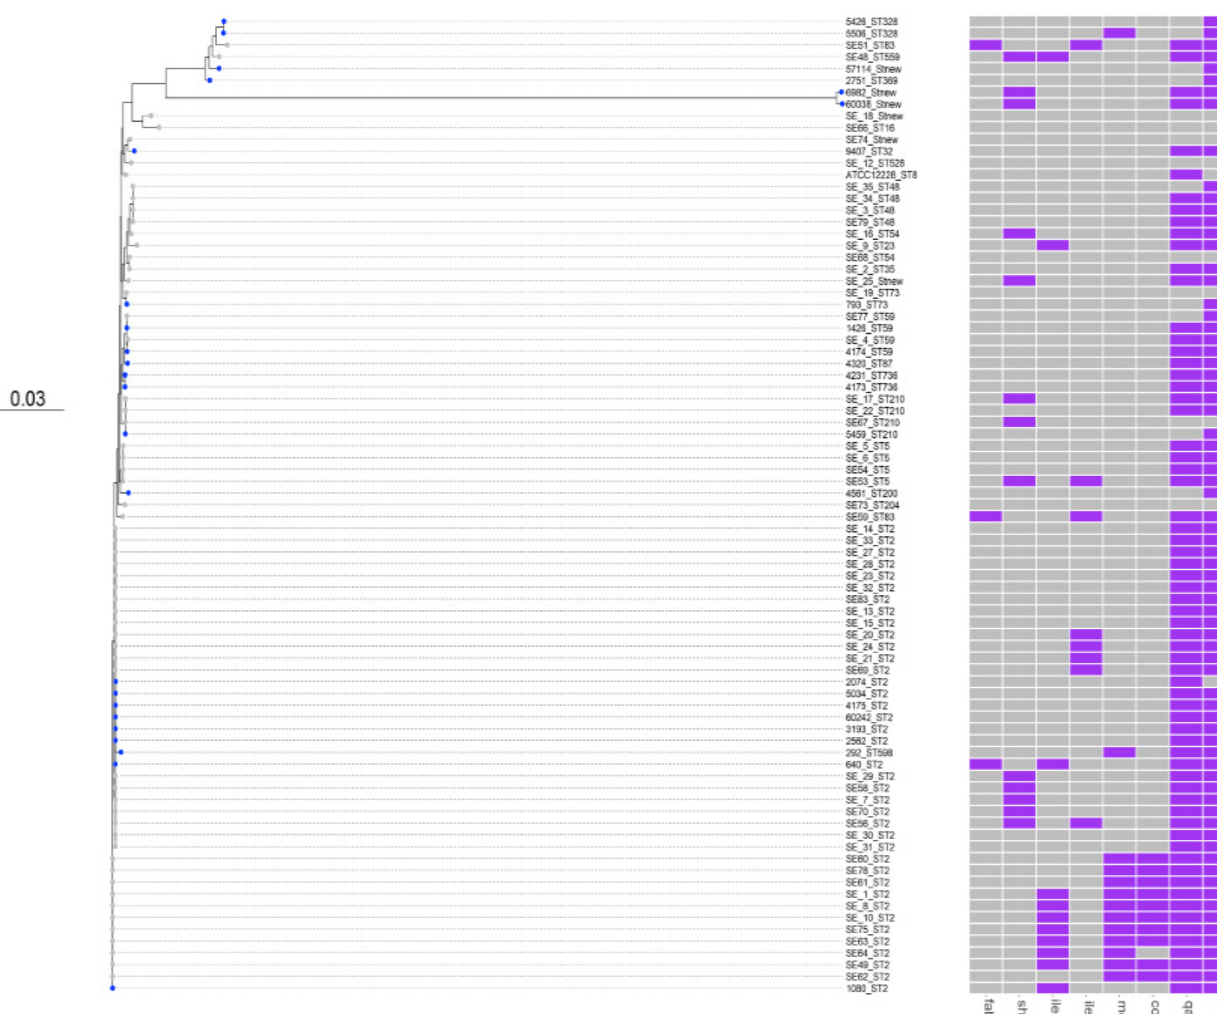
Figure 2. Core genome phylogenetic tree of S. epidermidis strains genomes from Aberdeen, UK. Maximum likelihood tree of the 24 isolates from Oman (Table 1) (isolates in marked in blue) and the data set from Aberdeen of 58 isolates (in gray) (NCBI BioProject number: PRJNA574294). As in Figure 1, the tree is annotated with the isolate’s sequence type (ST). Biocide’s tolerance genes ( qacA/B , fabI ) and an additional fabI allele derived from Staphylococcus haemolyticus ( sh-fabI ) are shown. ATCC 12228 is used as the reference strain in this phylogenetic tree (GenBank accession number: AE015929).